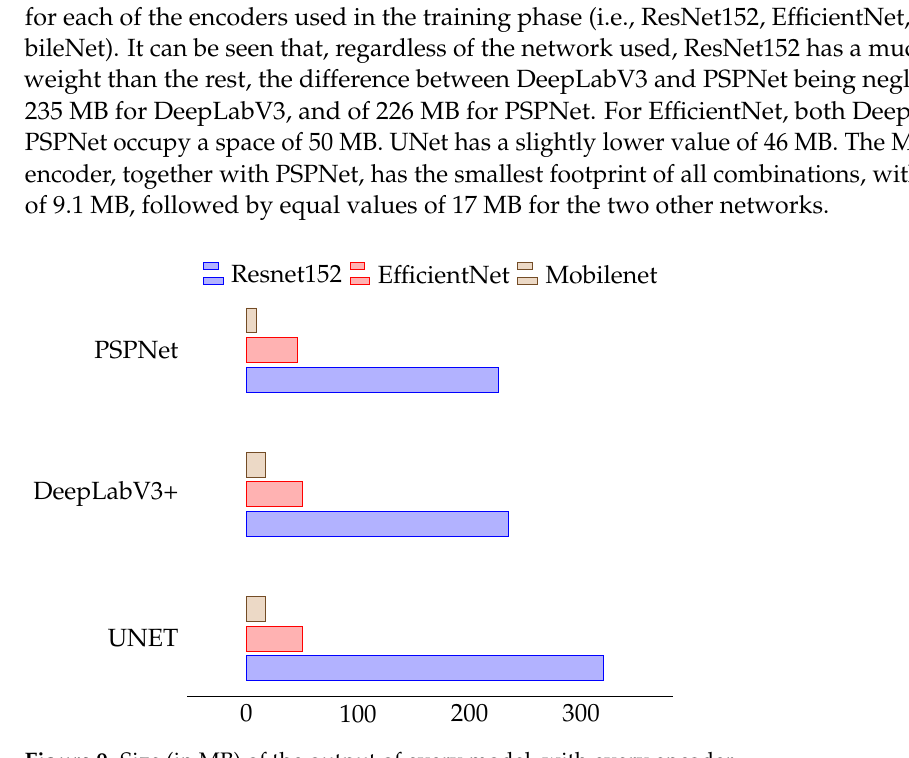
Figure 9. Size (in MB) of the output of every model, with every